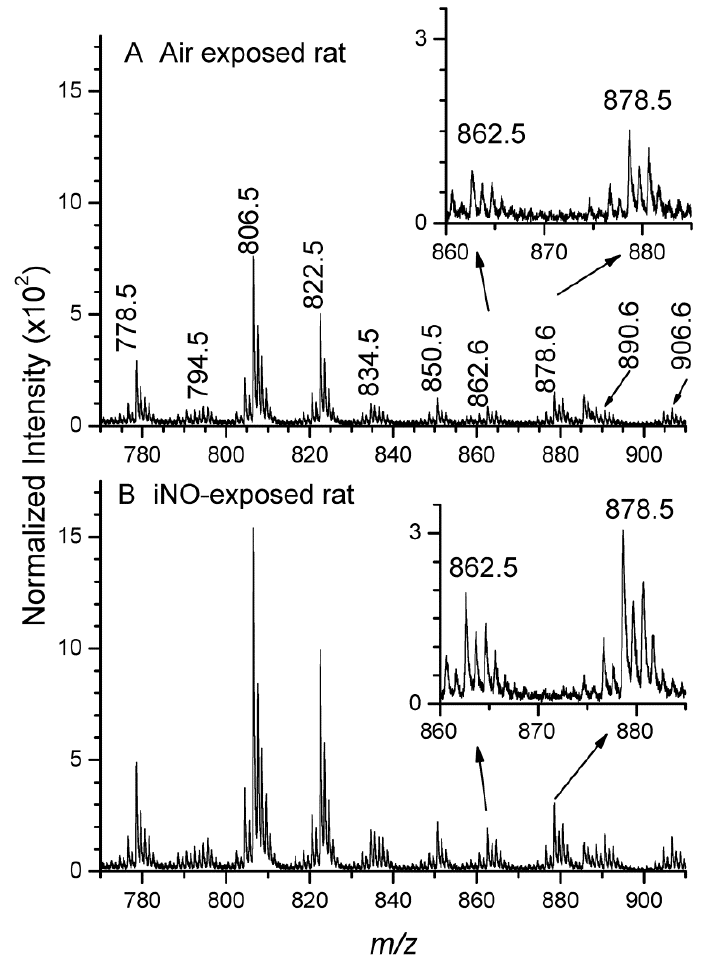
Figure 3. TOF-SIMS mass spectra ( m / z range 770–910) of areas corresponding to the white matter of P10 rat brain tissue sections. ( A ) air-exposed rat; ( B ) iNO-exposed